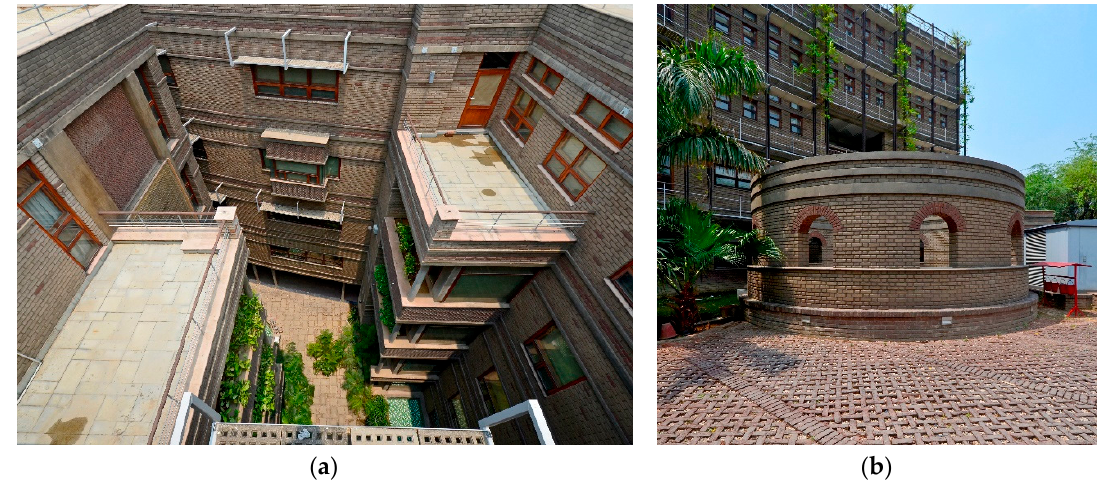
Figure 25. Traditional building elements such as the ( a ) courtyard and ( b ) baoli reinterpreted in the DA building (Photos: Author).